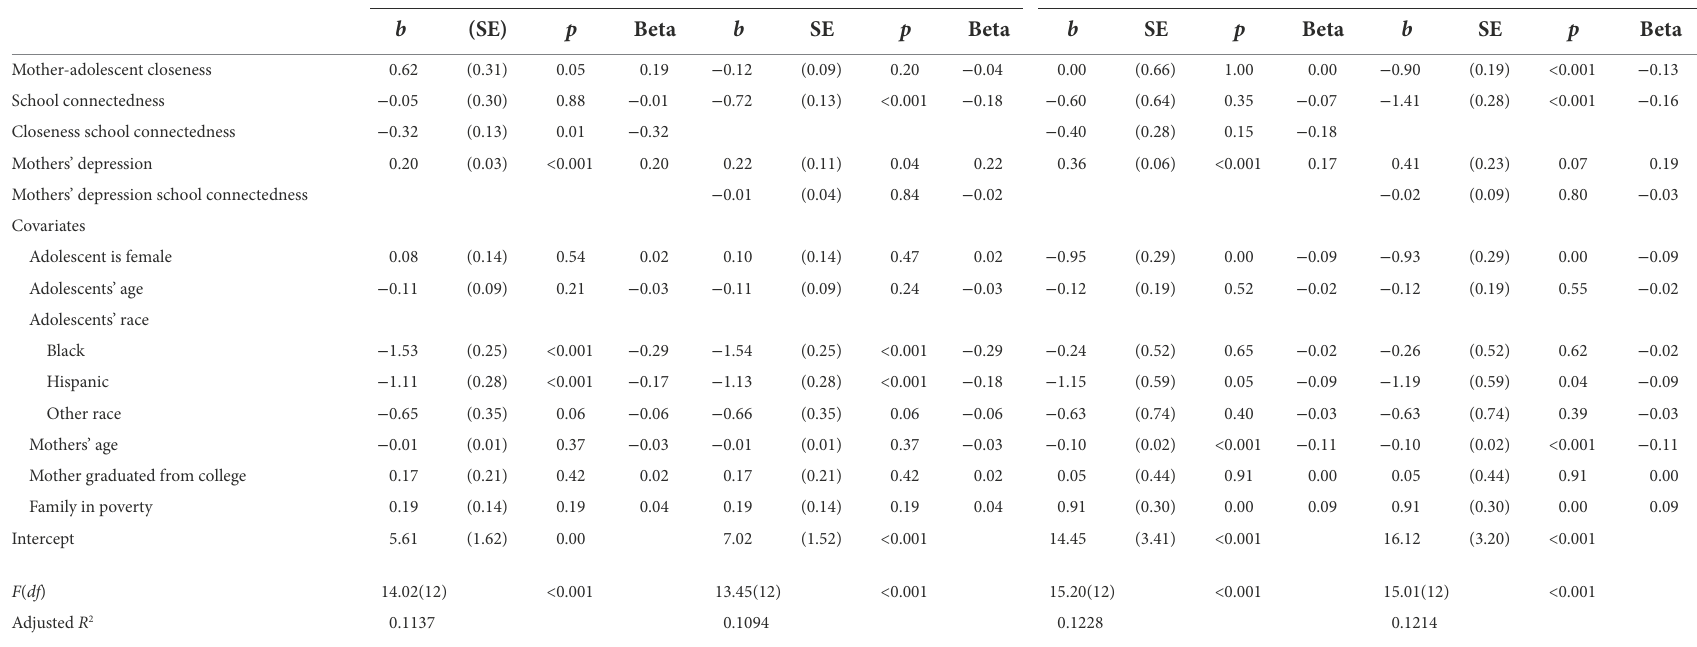
TABLE 5 Moderating effect of school connectedness ( N =